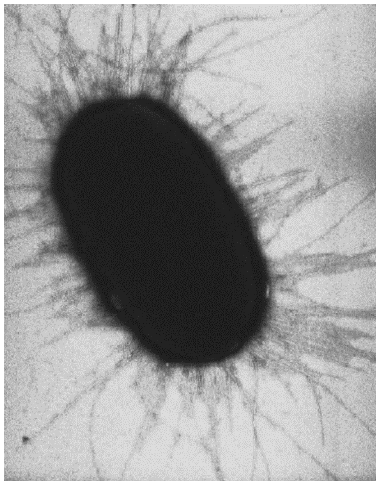
nal.pbio.0040314.g001.